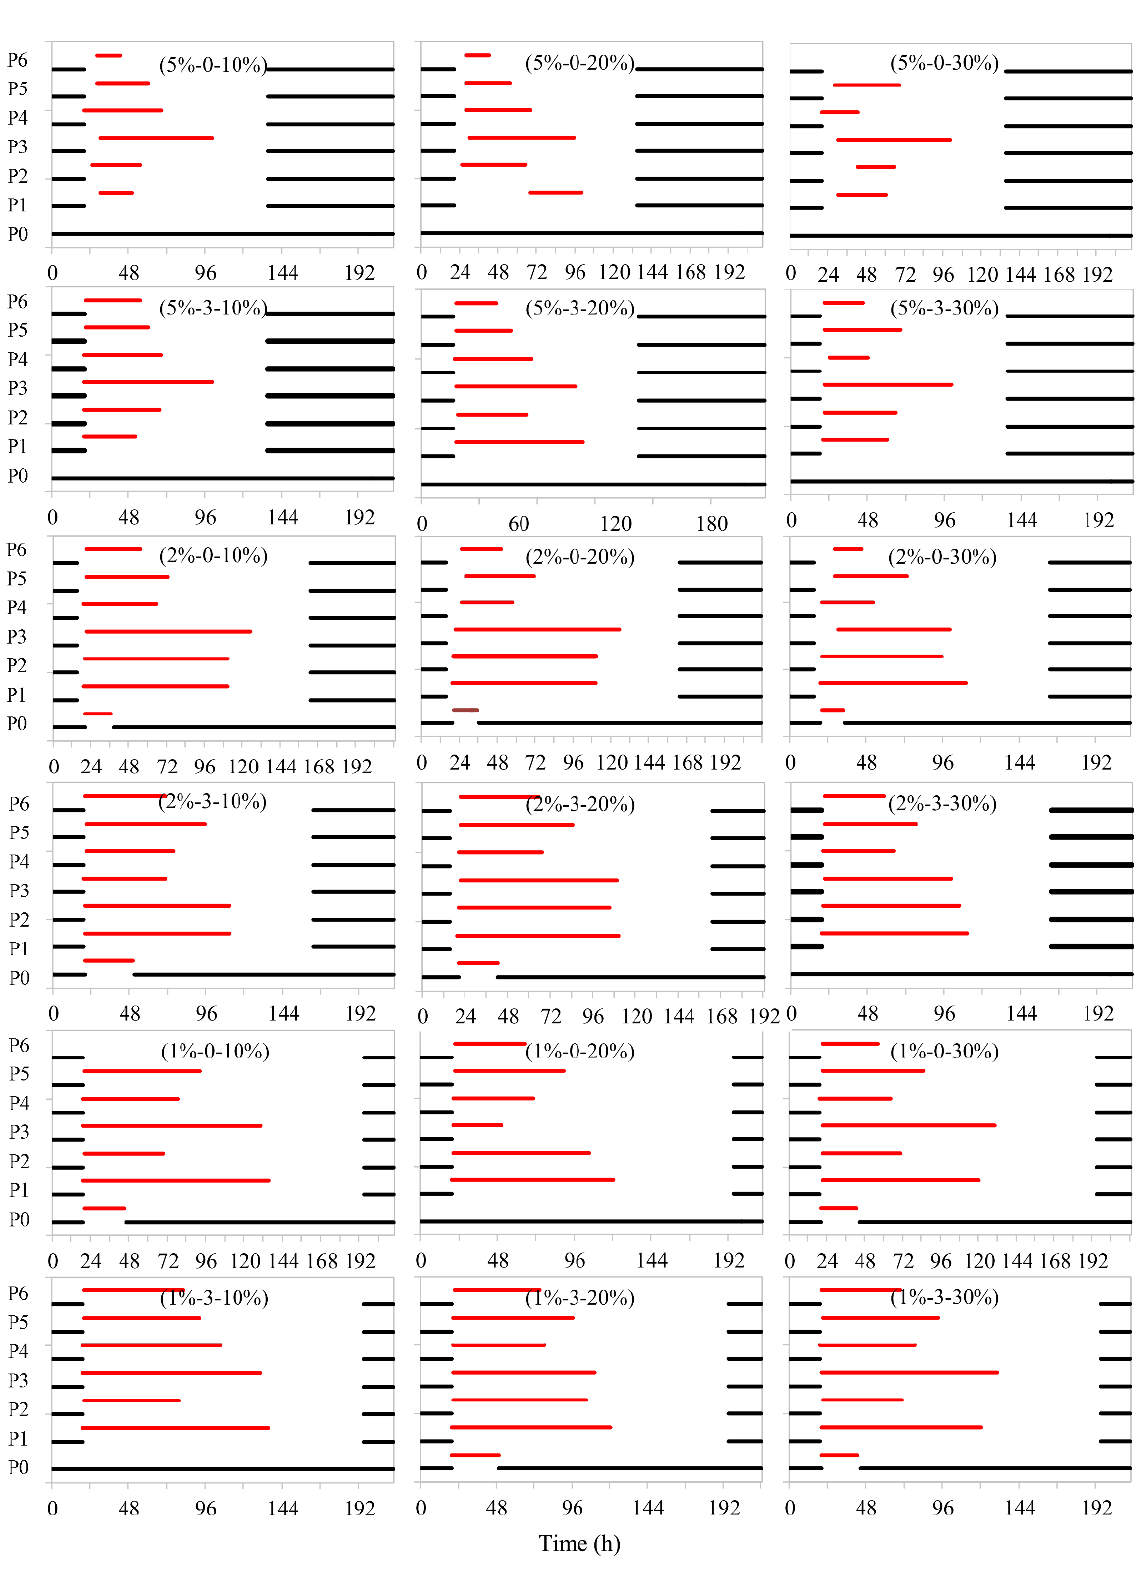
Figure 12. Scheduling schemes under different frequency rainfall conditions and work scale in the extreme climate scenario. (a–c, a: rainfall frequency, b: initial water level, c-work scale increased).